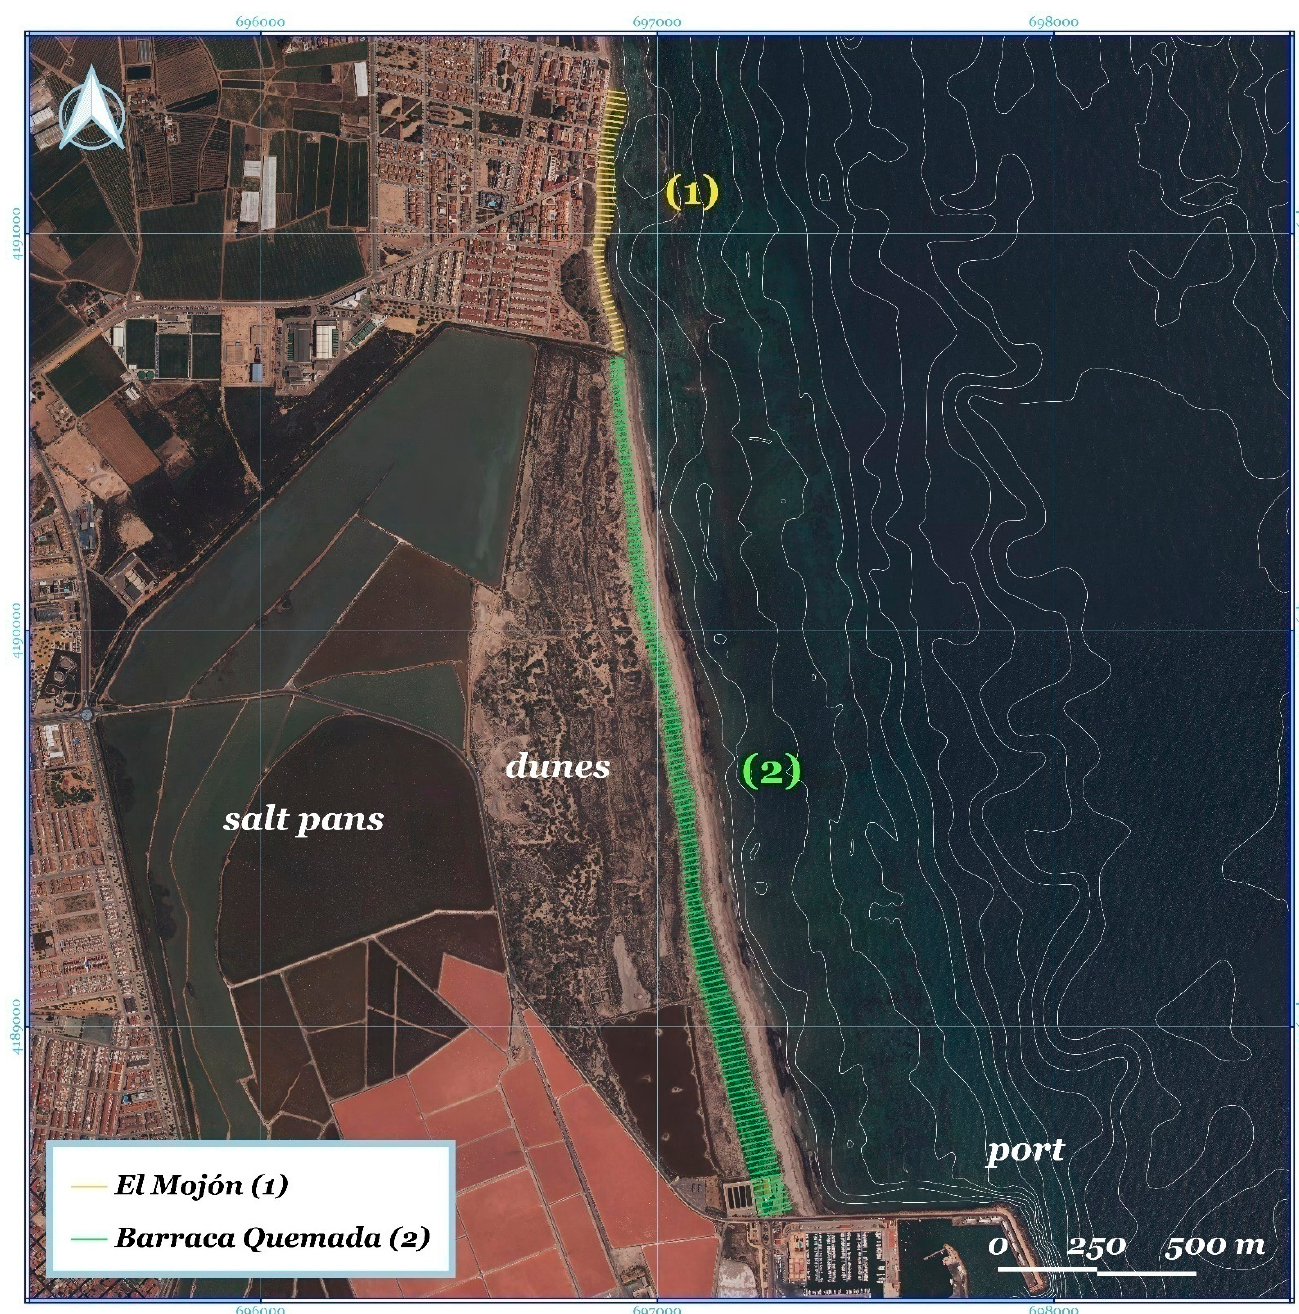
Figure 3. Sections located north of the Port of San Pedro del Pinatar. El Mojón Beach (1) and Torre Derribada Beach (2). Source: own elaboration.